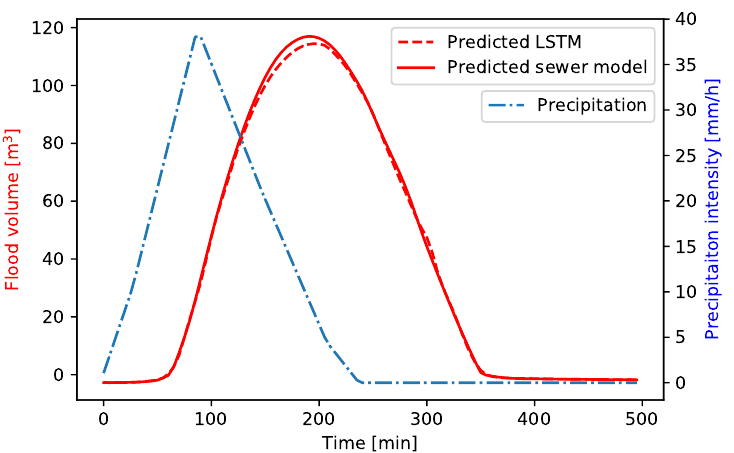
Figure 11. Flood volume time series, for the LSTM network validated on synthetic data, at a manhole in the centre of the area (NSE = 0.95).